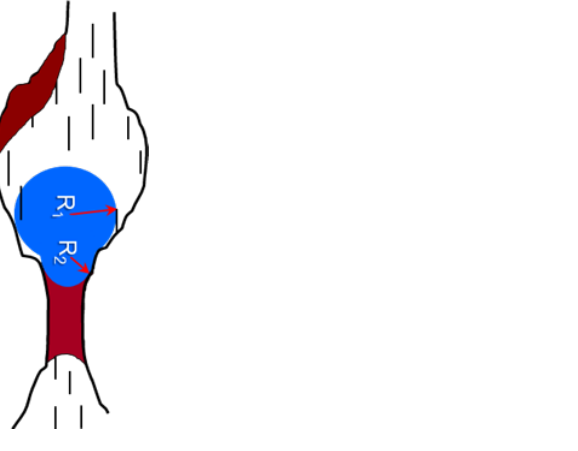
Figure 10. Schematic diagram of Jamin effect in gas displacement.